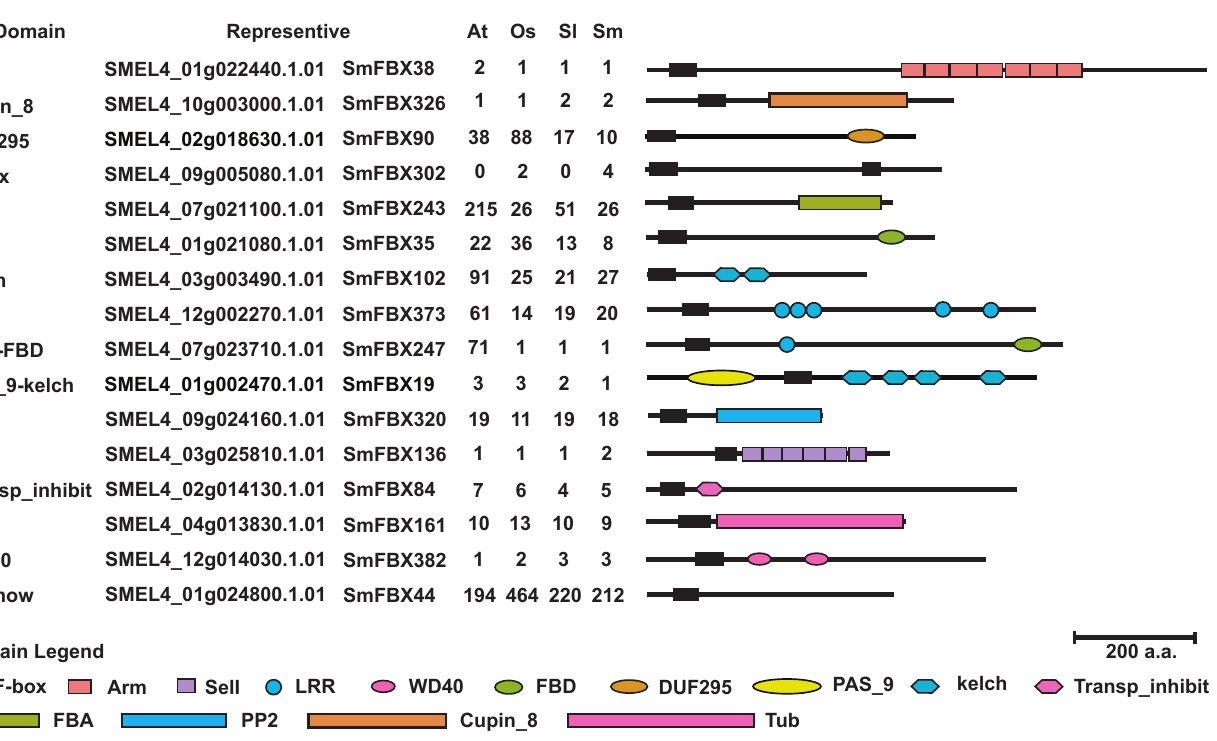
Figure 1. Schematic representation of representative F-box domains. A total of 16 representative F-box proteins were screened in Arabidopsis thaliana , rice ( Oryza sativa ), tomato ( Solanum lycopersicon ), and eggplant ( S. melongena ). The domain represents the type of C-terminal domain of the F-box candidate protein and counts the predicted number in the four